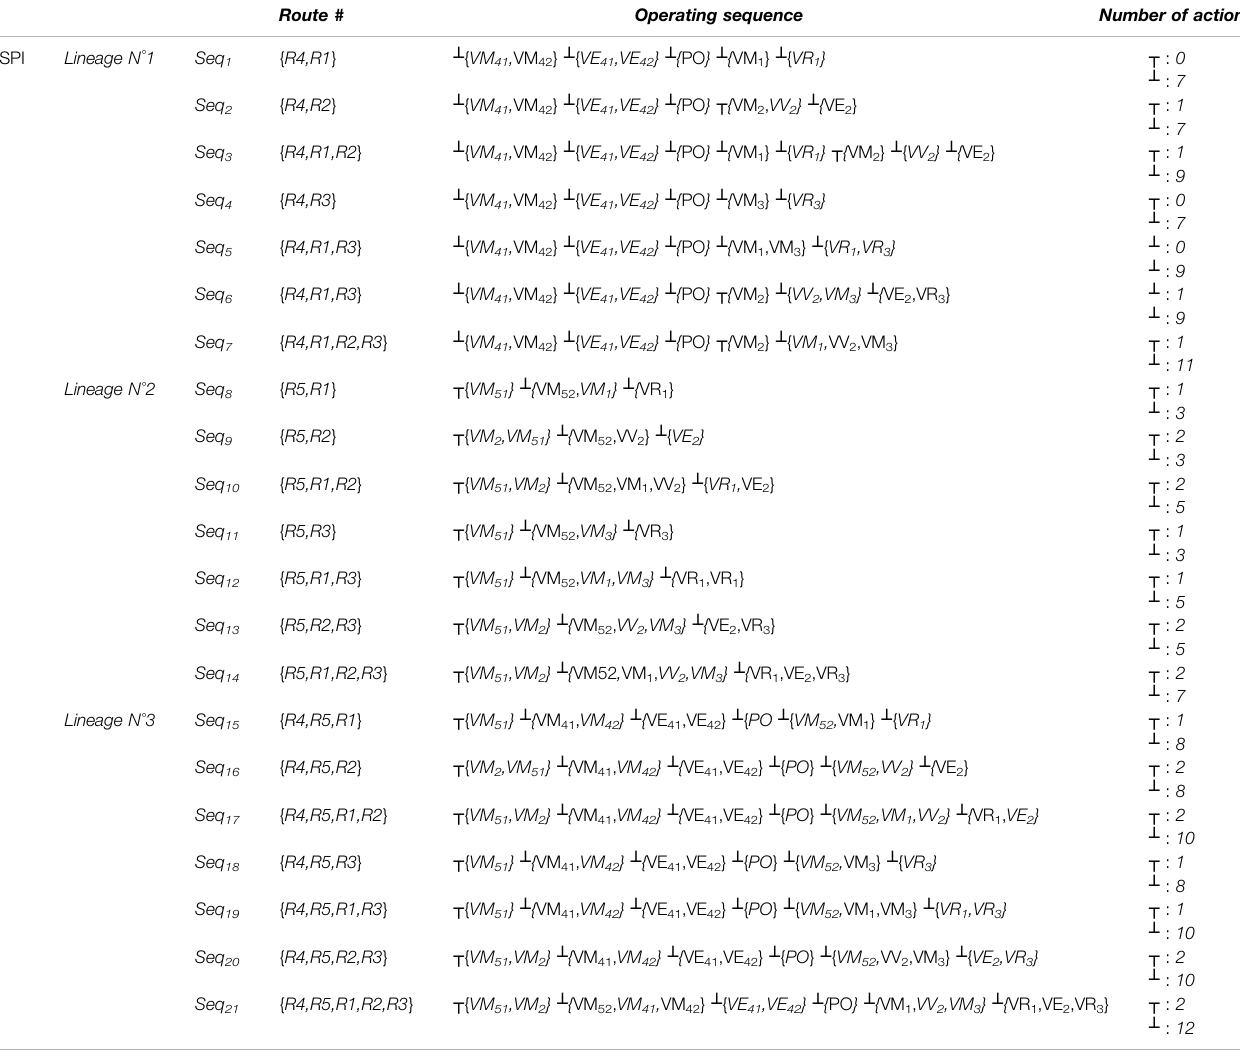
TABLE 4 | Complete set of operation sequences.